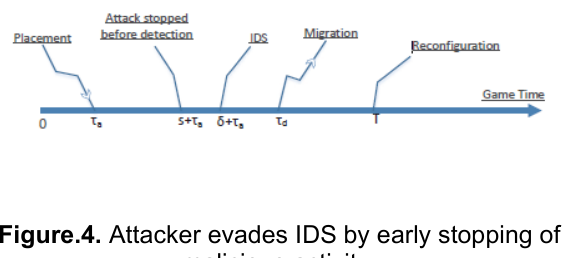
Figure.4. Attacker evades IDS by early stopping of malicious activity.